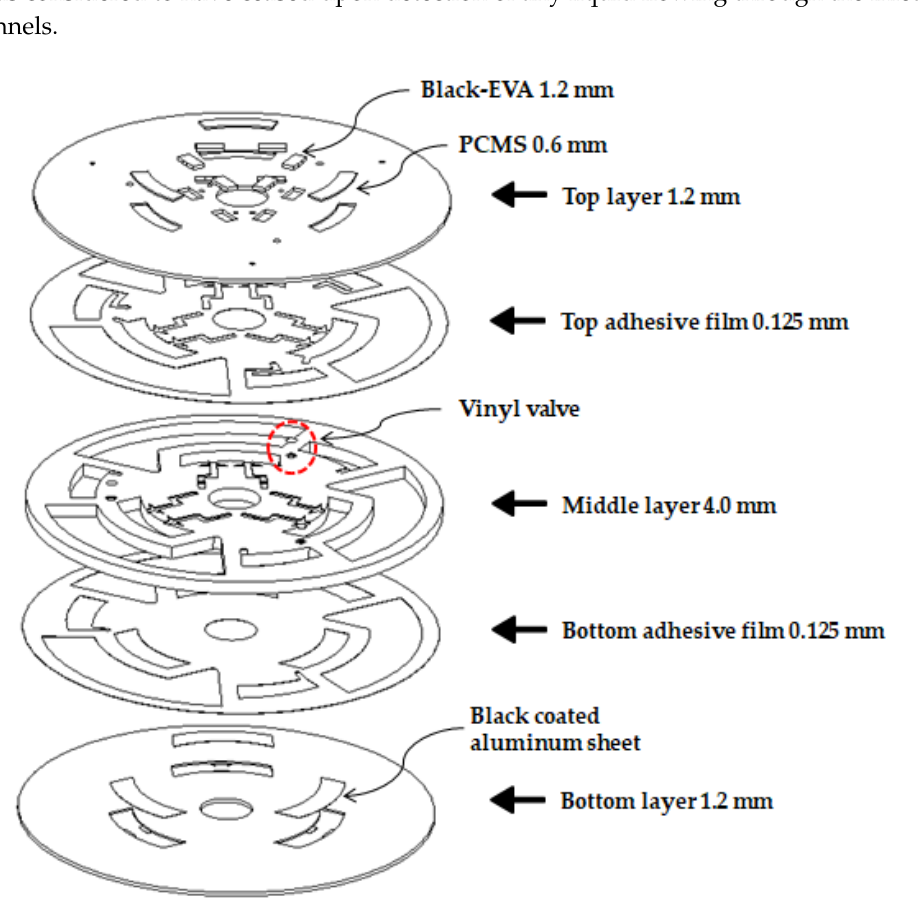
Figure 2. Three layer assembly drawing of Lab-on-disc (LOD). The three layers are made of polycarbonate (PC) plates and bonded with a double-sided adhesive.